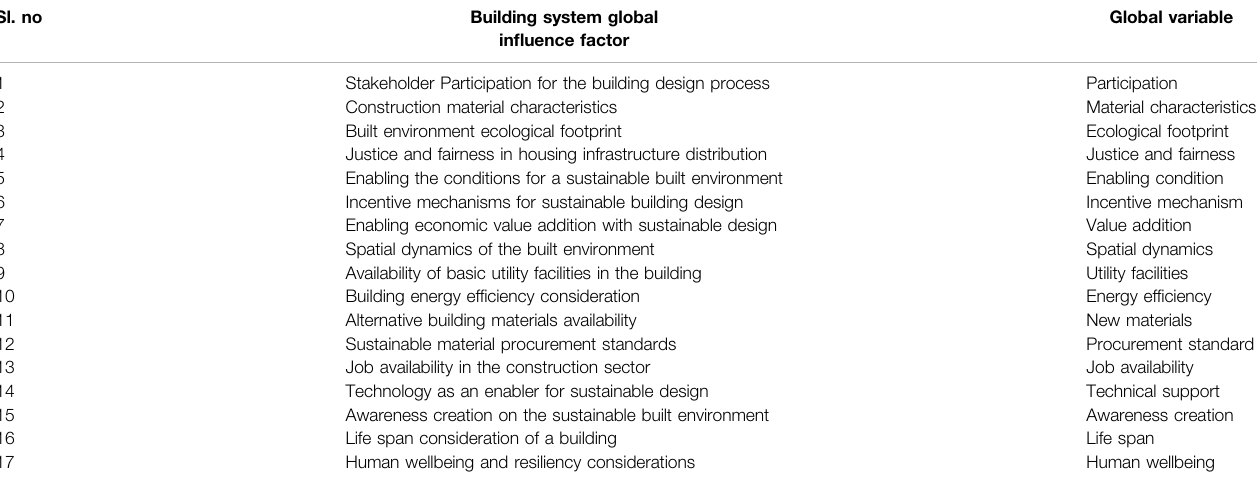
TABLE 2 | Building system